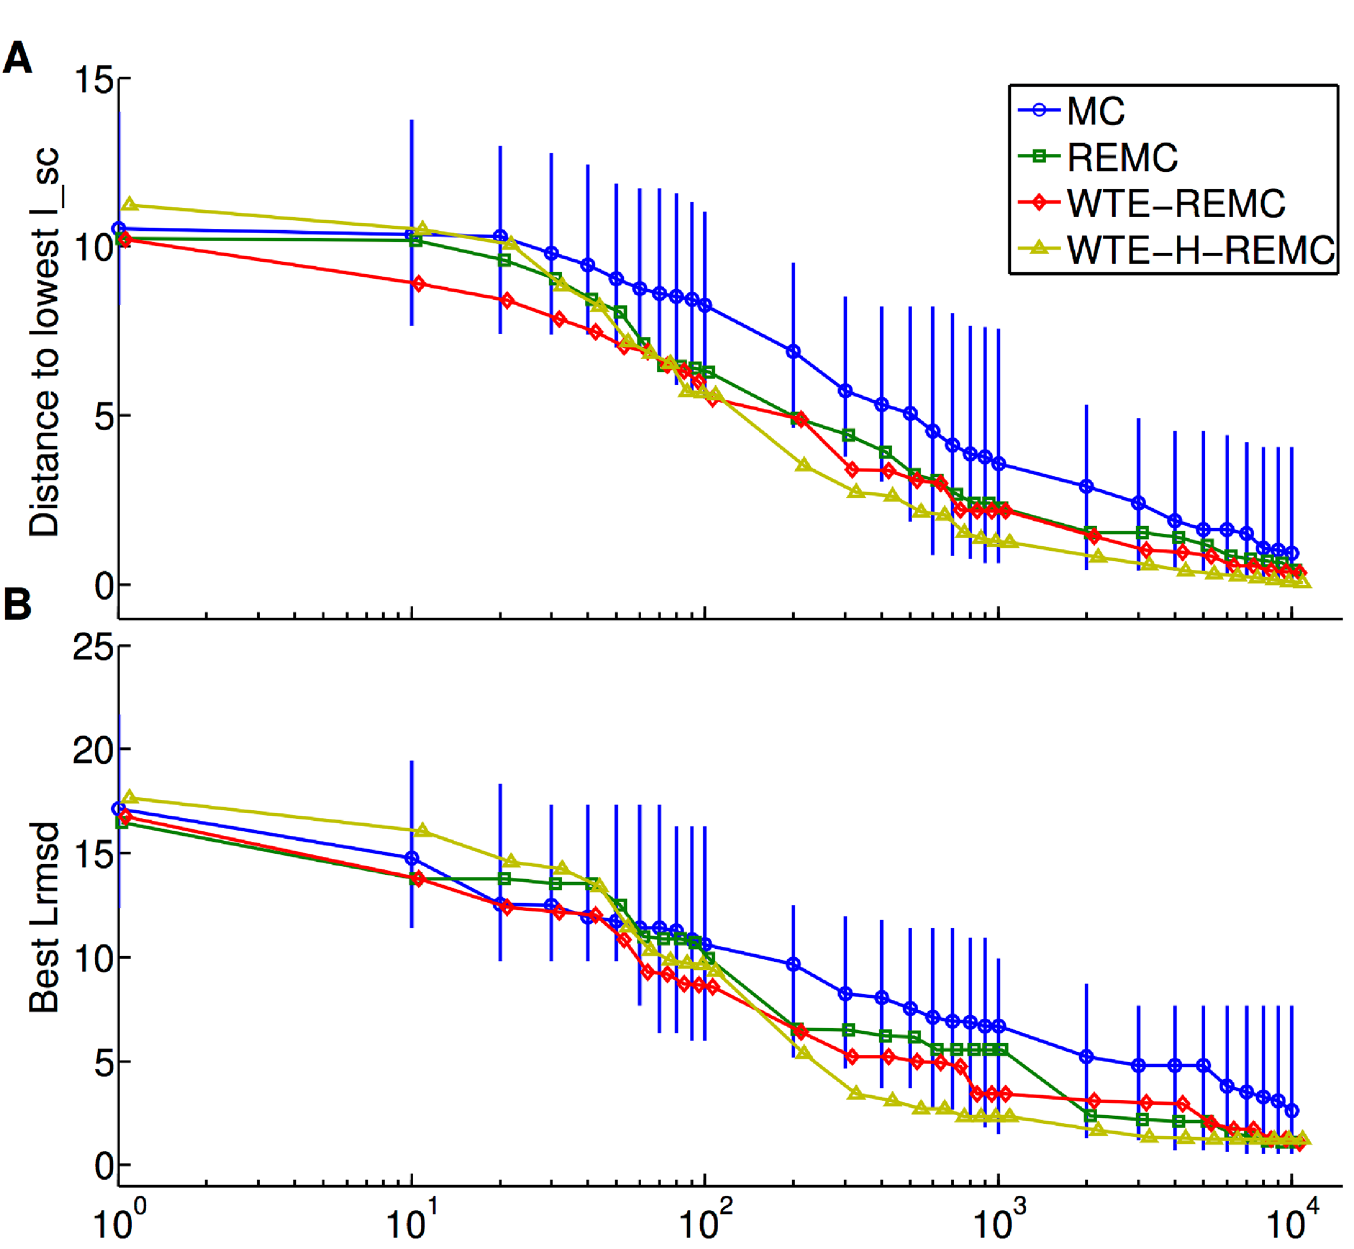
Fig 5. Evolution of I_sc docking interaction score (A) and best sampled Lrmsd (B) vs. MC step number. The MC step number is scaled by x1000. For the interaction score I_sc the smallest difference (sampled up to the selected step number) relative to the lowest scoring complex sampled in the entire docking search is plotted. The variance in sampled scores (up to the considered number of MC steps) is indicated by error bars for the MC protocol. It is of similar magnitude for the other protocols (not shown). For (B) the smallest sampled L_rmsd up to the step number indicated in the x-axis is shown.